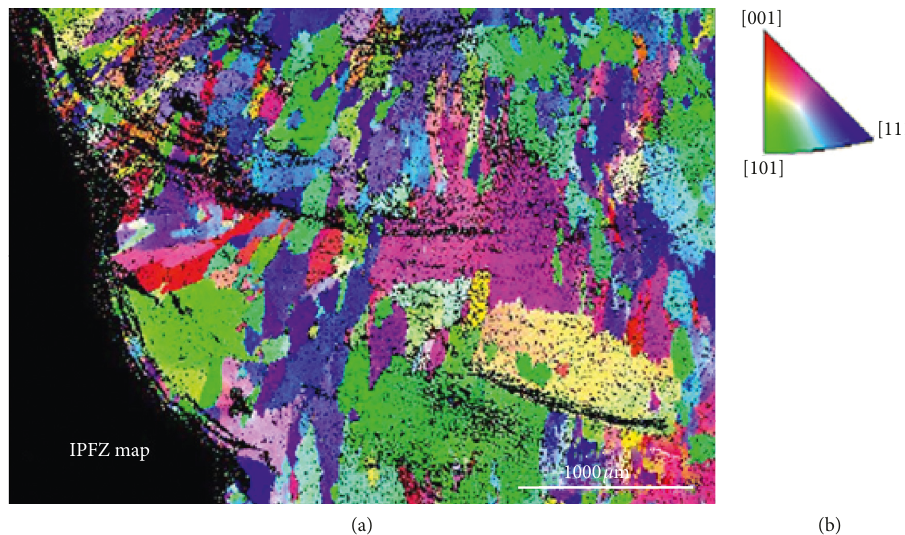
Figure 16: Grain orientation distribution of weld.